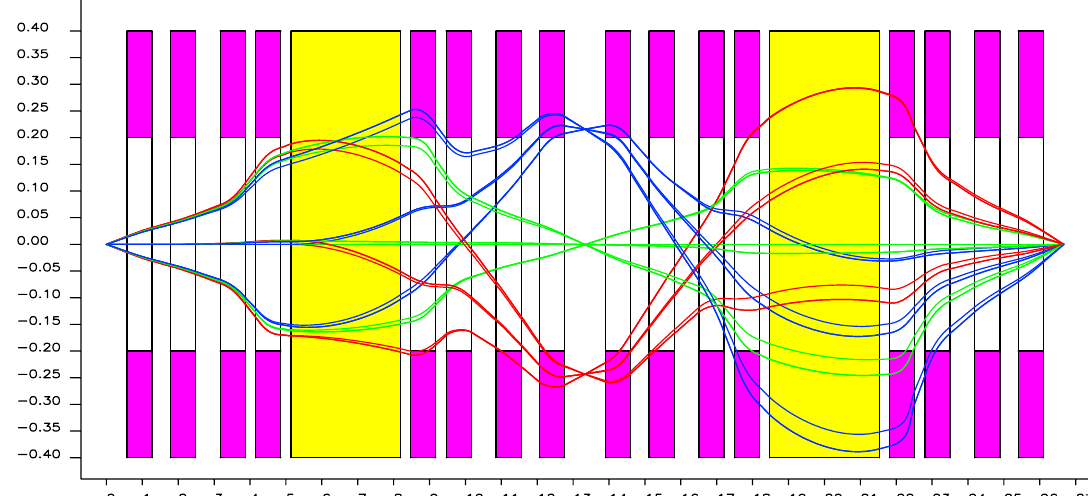
FIG. 5. (Color) Alternate design, which cancels the positional aberrations at the dispersive plane at the detriment of some angular aberrations.